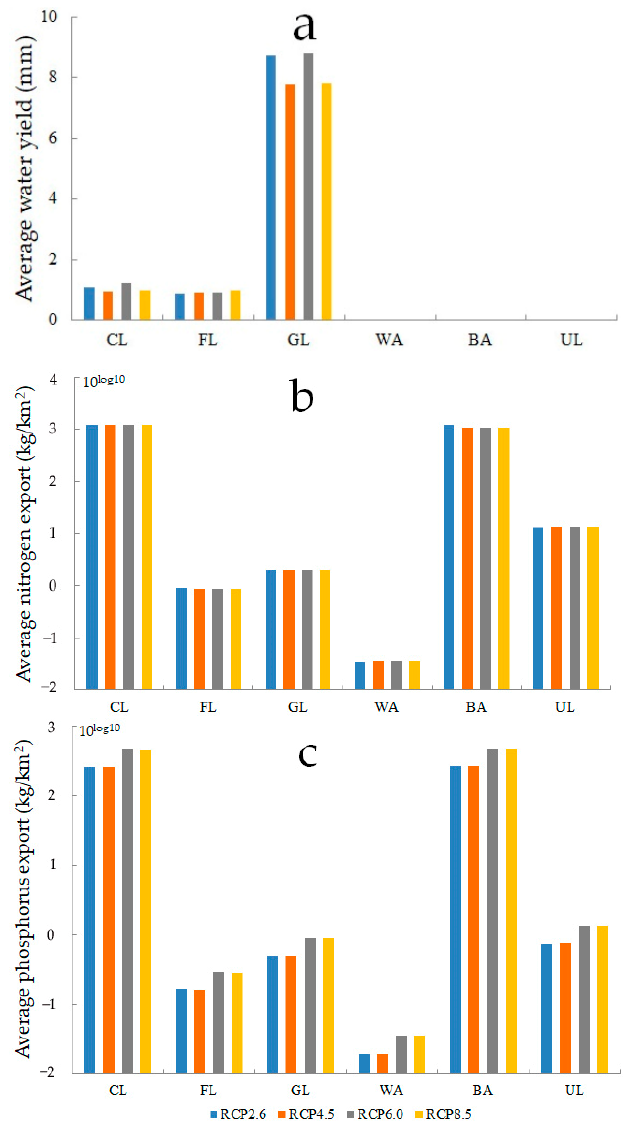
Figure 10. Average water yield ( a ), average nitrogen export ( b ) and average phosphorus export ( c ) of different land use types in 2050 for RCP scenarios.